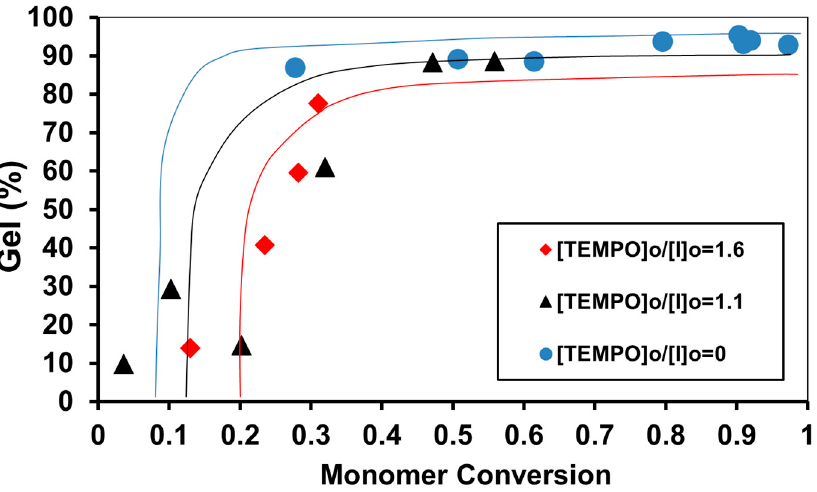
Figure 11. Effect of controller (TEMPO) content on the evolution of gel percentage versus conversion for the NMC of STY/DVB in scCO 2 at [DVB] = 1 wt.%, T = 120 °C, and P = 207 bar.